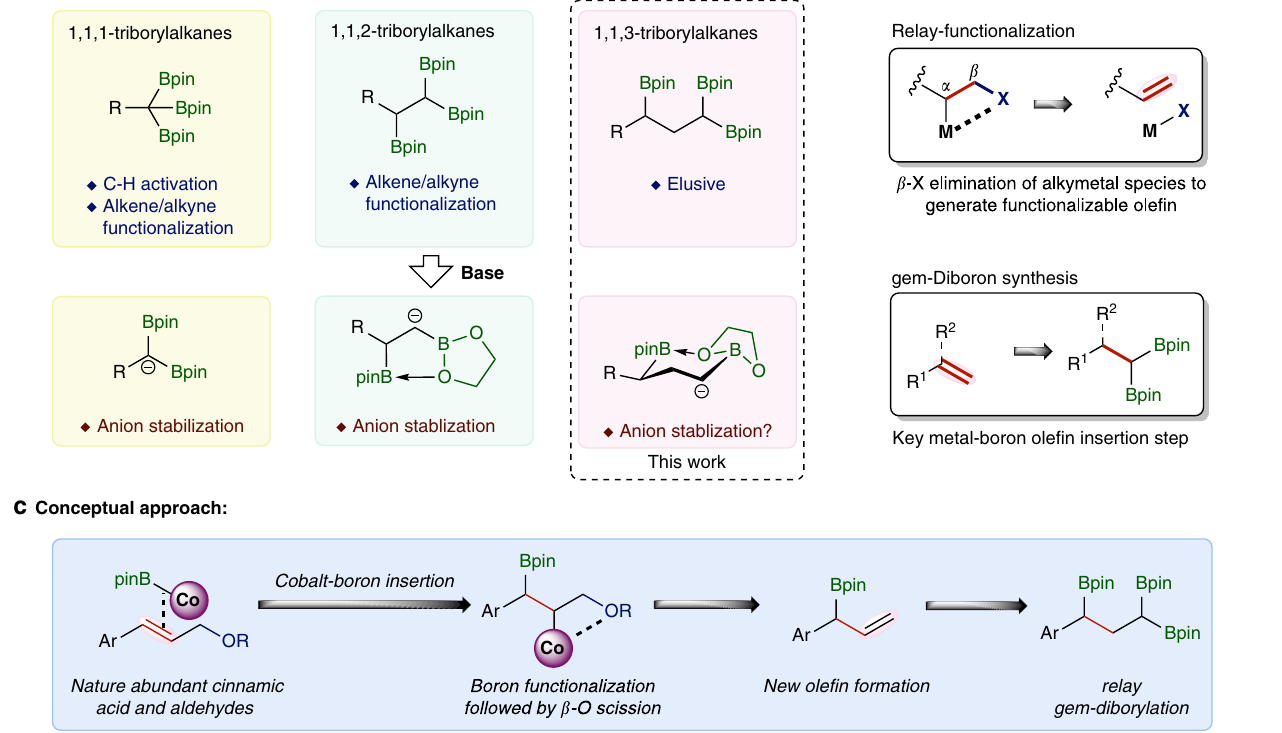
Fig. 1 Introduction and the proposed synthesis of triborylalkane compounds. a Triborylalkane compounds. b Current strategies of relay functionalization and gem -diborylation. c Conceptual design of cobalt-catalyzed deoxygenative